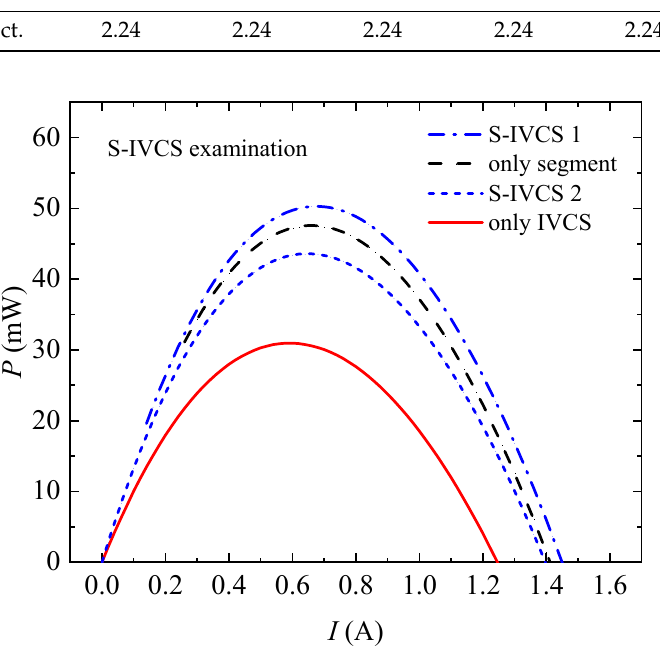
Figure 6. Comparison of the unit power as a function of current with various designs of only segmented, only IVCS, S-IVCS 1, and S-IVCS 2. Here, the material volume of the different designs keeps the same.